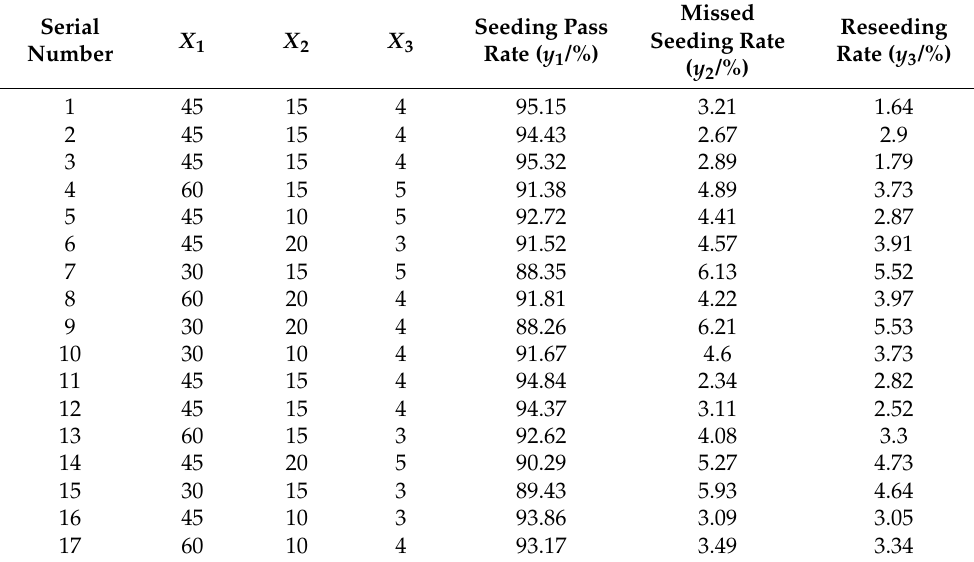
Table 3. Test factors and indicators.